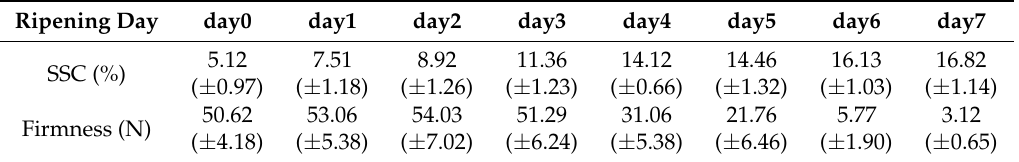
Table 3. Average values ( ± standard deviation) of soluble solids content (SSC) and firmness at different ripening days.